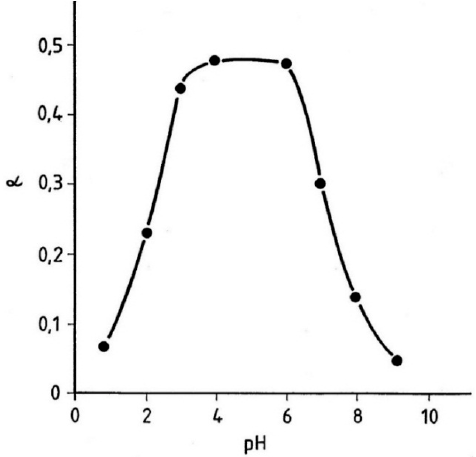
Figure 29. Effect of pH on the reaction of hair with sulfite, adapted from Wolfram et al. [20], with permission from SAGE Publications, 1966.